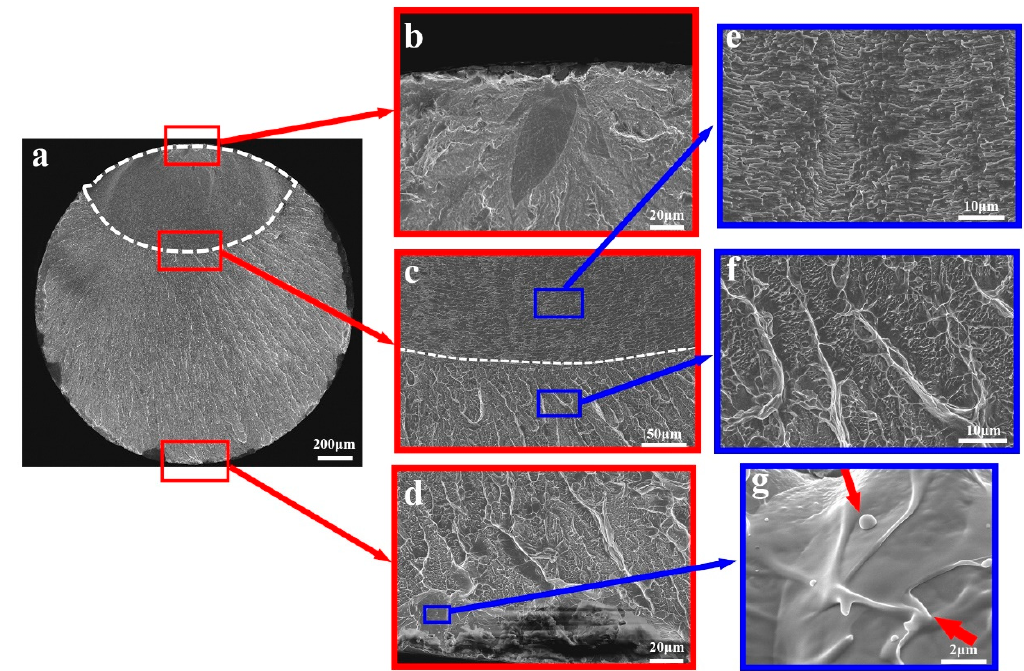
Figure 7. Fractograph morphology of a brittle Mg-Cu-Ag-Y MG after tension fatigue fracture. ( a ) The overall appearance of the fractograph. ( b ) Enlarged image of the crack initiation site. ( c ) The boundary between the regular fatigue striations and the fast fracture region. ( d ) The morphology at the end of the fractograph. ( e ) Enlarge image of the regular fatigue striations. ( f ) Enlarged image of the fast fracture region ( g ) Enlarge image of the droplet feature at the end of the